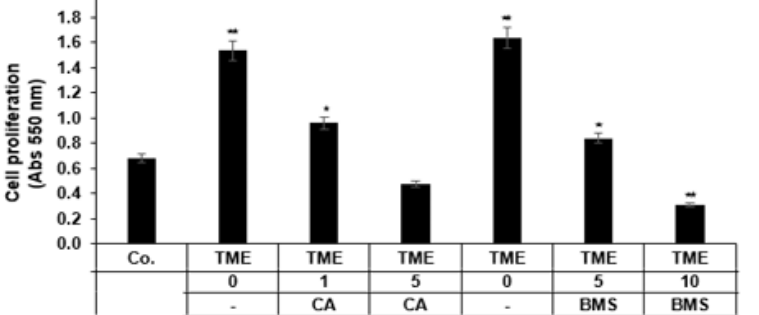
Figure 2. E ff ect of Calebin A (CA) or specific IKK inhibitor BMS-345541 on the proliferation of CRC cells: Serum starved HCT116 cells in alginate beads from the basal control and multicellular TME cultures were treated as described in Materials and Methods. Cell proliferation was analyzed with the MTT method. All experiments were performed at least three times. p < 0.05 (*) and p < 0.01 (**) indicate a significant di ff erence compared to the control group.